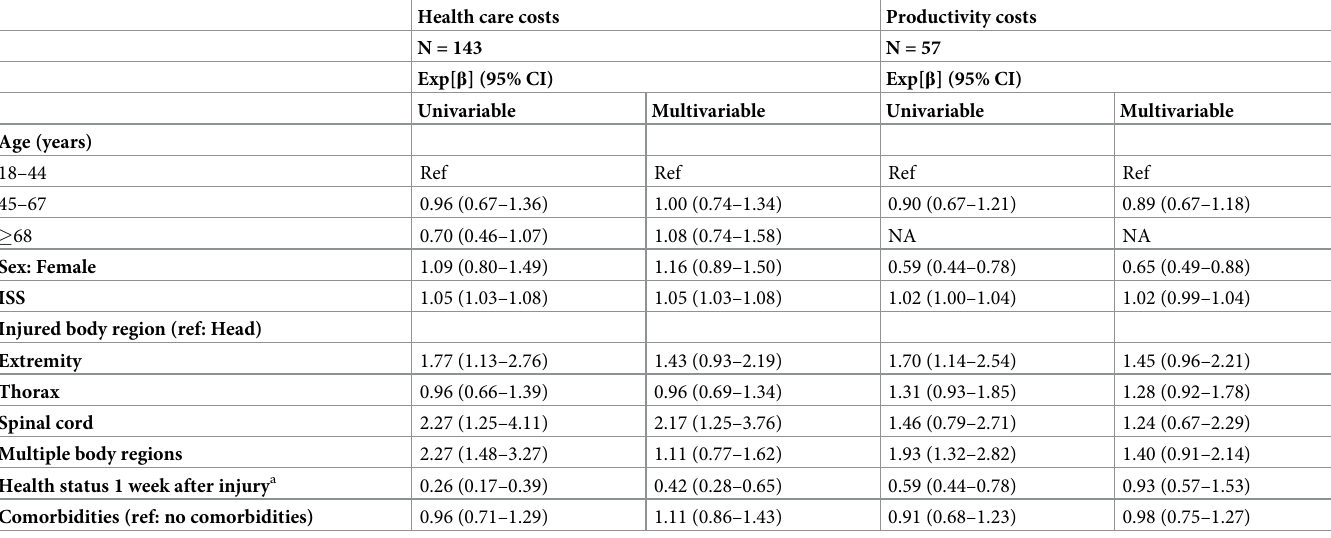
Table 4. Associations with total health care costs and productivity costs based on generalized linear